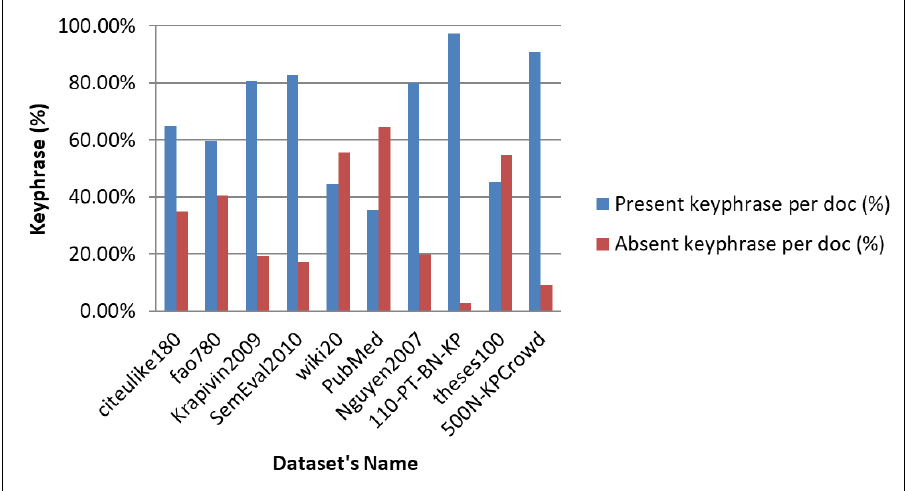
Figure 4. Analyze the Avg percentage (%) of present and absent keyphrases per doc for all